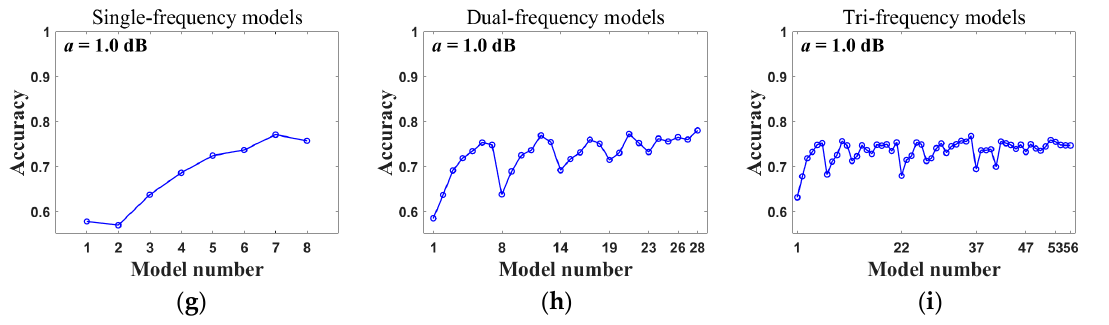
Figure 9. Test set accuracy of the ELM for single-frequency, dual-frequency, and tri-frequency models. (a), (b) and (c) represent the single-frequency, dual-frequency, and triple-frequency models for a = 0.3 dB, respectively. (d), (e) and (f) represent the single-frequency, dual-frequency, and triple-frequency models for a = 0.5 dB, respectively. (g), (h) and (i) represent the single-frequency, dual-frequency, and triple-frequency models for a = 1.0 dB, respectively.